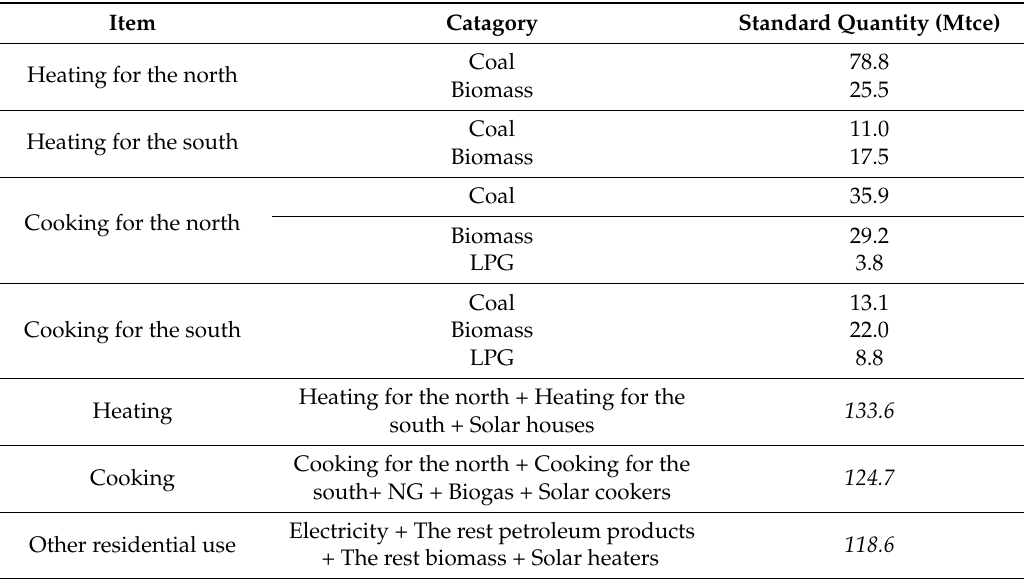
Table 4. Main sectors of energy consumption considered in the